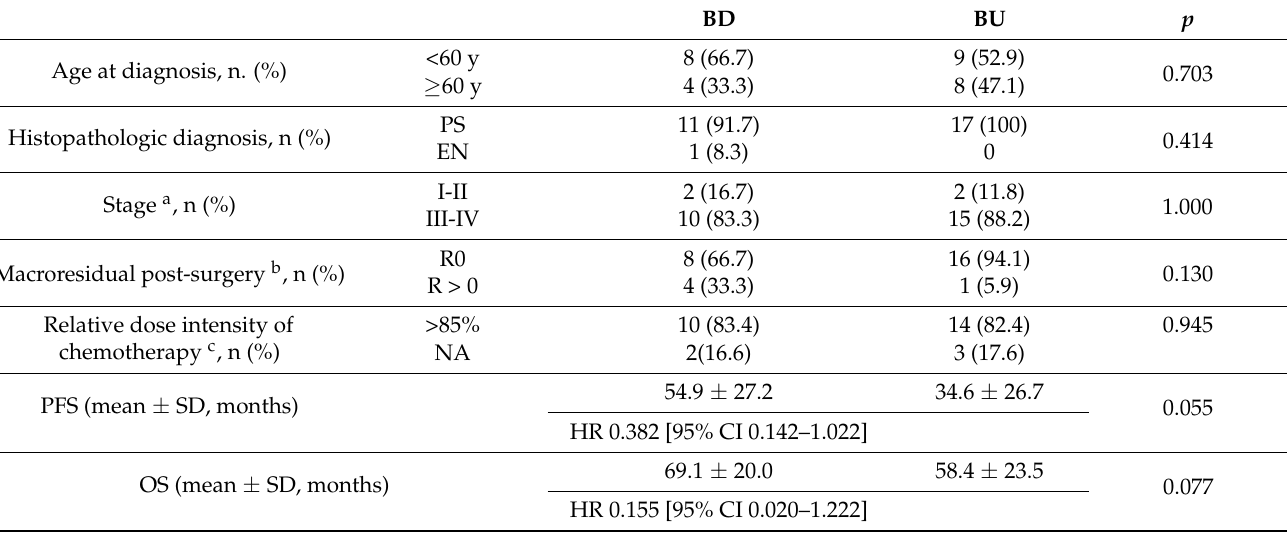
Table 5. Comparison of clinical characteristics and outcomes between BD and BU patients. BD BU p Age at diagnosis, n.